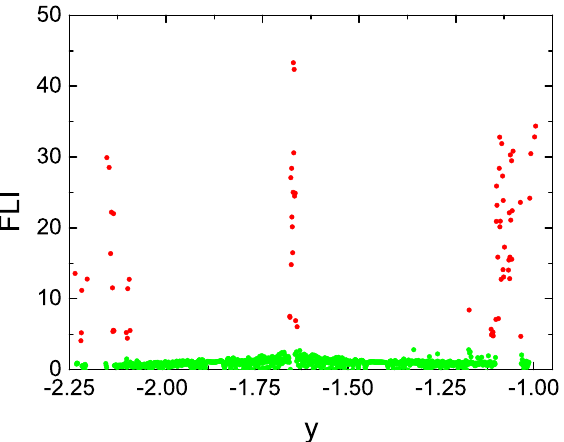
Figure 7. Dependence of FLI on initial value y , described by algorithm N4P with the larger time step τ = 0.1. Initial value x = 0 is fixed. Each of the FLIs is obtained after integration time t = 3 × 10 3 . The FILs less than 4 correspond to the regularity of orbits, whereas the FILs larger than 4 indicate the chaoticity of orbits. Green corresponds to the regularity of orbits, and Red indicates the chaoticity of orbits. Chaos mainly occurs for the initial values of y in the vicinity of − 2.25 ∼− 2.1, − 1.6, and − 1.2 ∼−